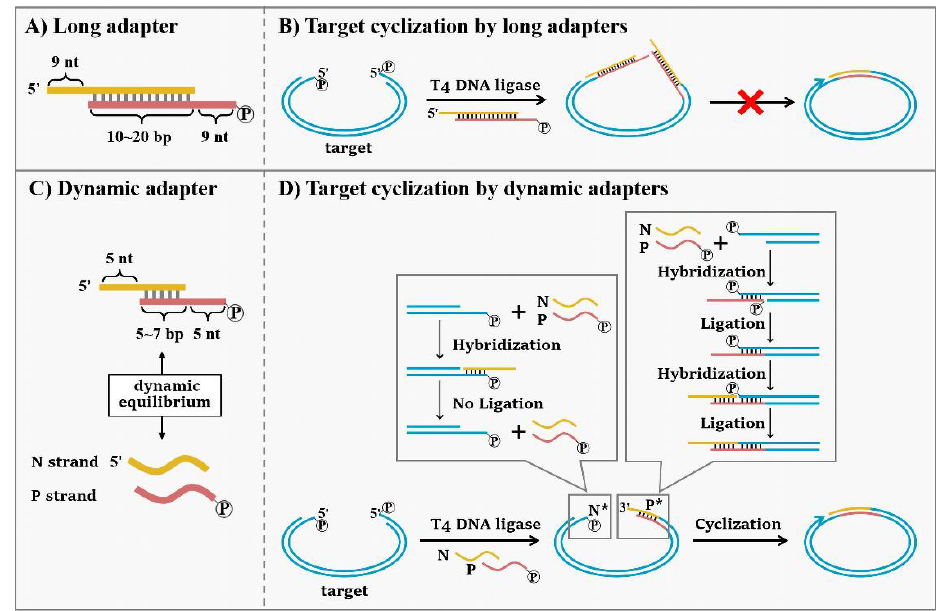
Scheme 2. Molecular design of adapters for target cyclization. ( A ) The structure of long double- stranded adapters. ( B ) Target cyclization by adapters with the long duplex part. The adapters ligate on both sides of the target so that the cyclization cannot proceed. ( C ) The structure of short dynamic adapters. ( D ) Target cyclization by dynamic adapters. The short dynamic adapters ligate at the P*